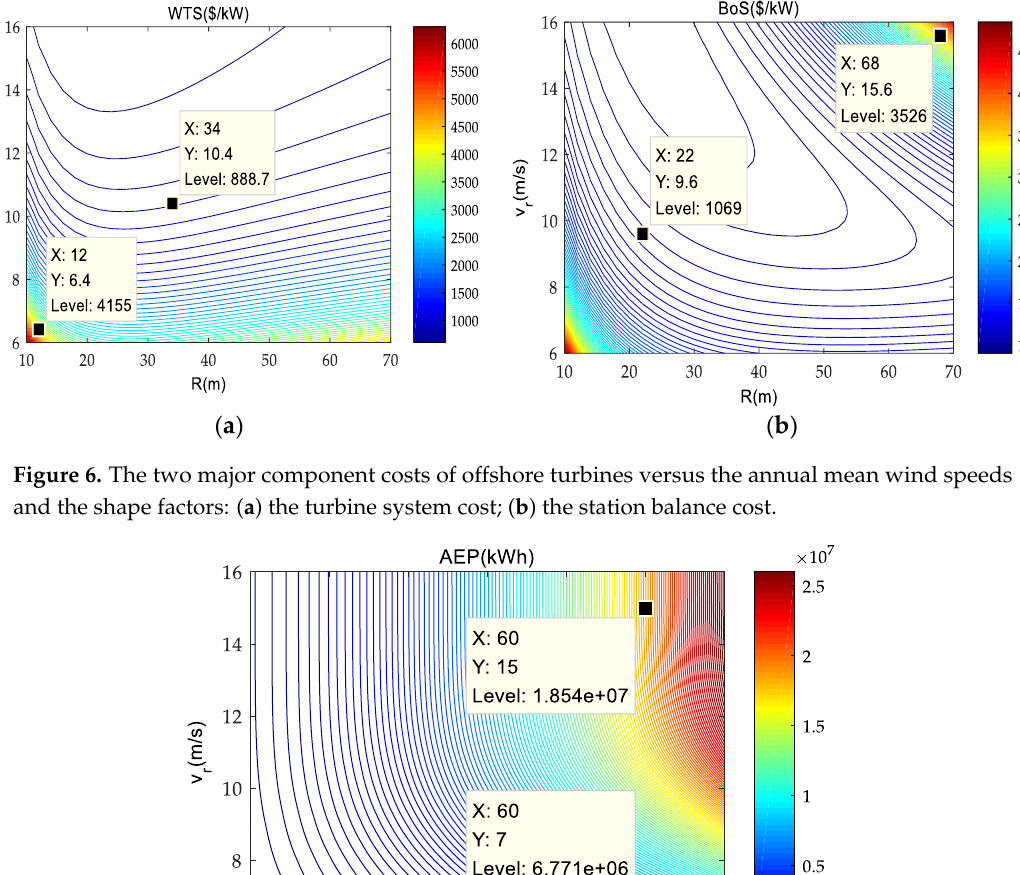
Figure 7. The obtained annual energy production versus the rotor radius and the rated wind speed.